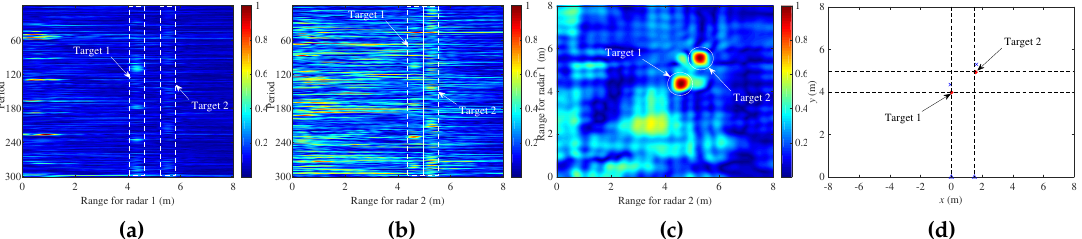
Figure 17. Results of Experiment 3.2: ( a ) range profile plane for Radar 1; ( b ) range profile plane for Radar 2; ( c ) cross-correlation image; and ( d ) localization result.